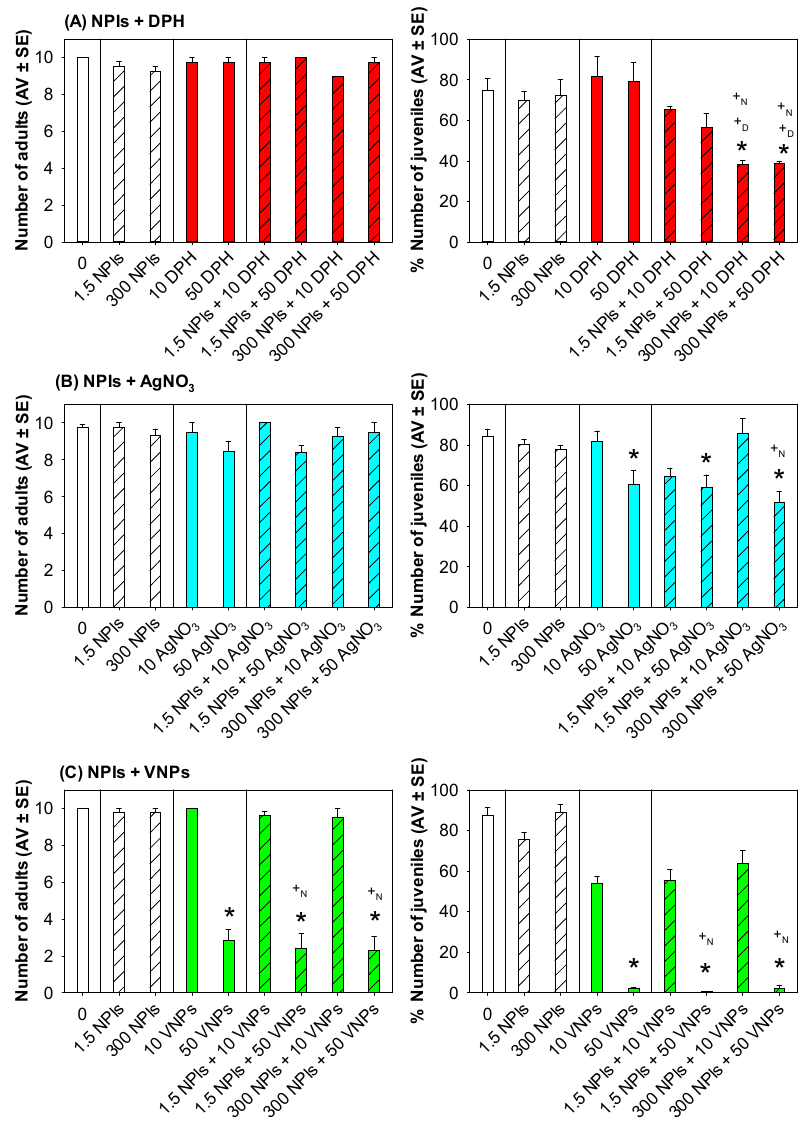
Figure 1. E. crypticus survival (number of adults) and reproduction (number of juveniles) after 28 days combined exposure in LUFA 2.2 soil to polystyrene nanoplastics (NPls) and ( A ) diphenhydramine (DPH), in red; ( B ) silver nitrate (AgNO 3 ), in blue; or ( C ) vanadium nanoparticles (VNPs), in green. Dashed bars represent treatments with NPls. Data are expressed as average value (AV) ± standard error (SE). * Significant differences to control ( p < 0.05). +D Significant differences to the correspondent DPH single exposure ( p < 0.05). +N Significant differences to the correspondent NPls single exposure ( p < 0.05).